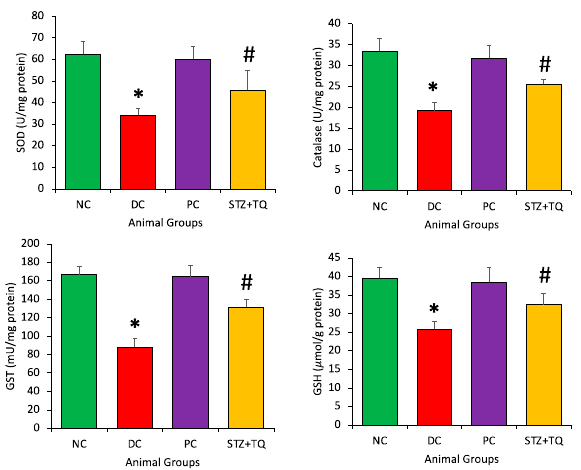
Figure 6. The antioxidant enzymes and antioxidant profile in different groups of rats after 8 weeks of follow up. The experimental animals were evenly distributed into different groups ( n = 8 per group). Data are means ± standard error of the mean (SEM). Groups: Normal control (NC); disease control (DC) i.e., STZ ‐ treated group; positive control (PC) animal treated with STZ and Glibenclamide; diabetic rats treated with TQ (STZ + TQ). * p < 0.05 (significant difference of be ‐ tween DC vs. NC), # p < 0.05 (significant difference between DC vs. STZ + TQ).